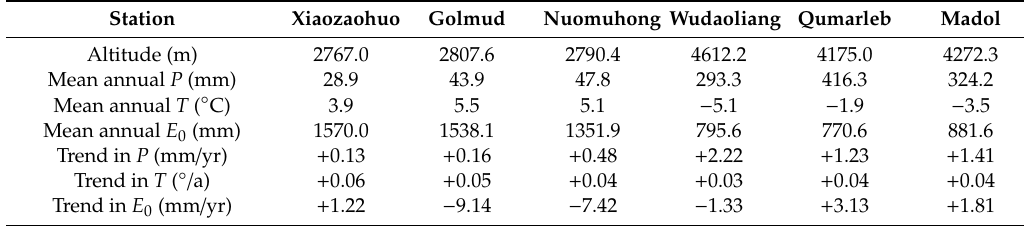
Table 1. Background data of meteorological stations (period 1965–2015).